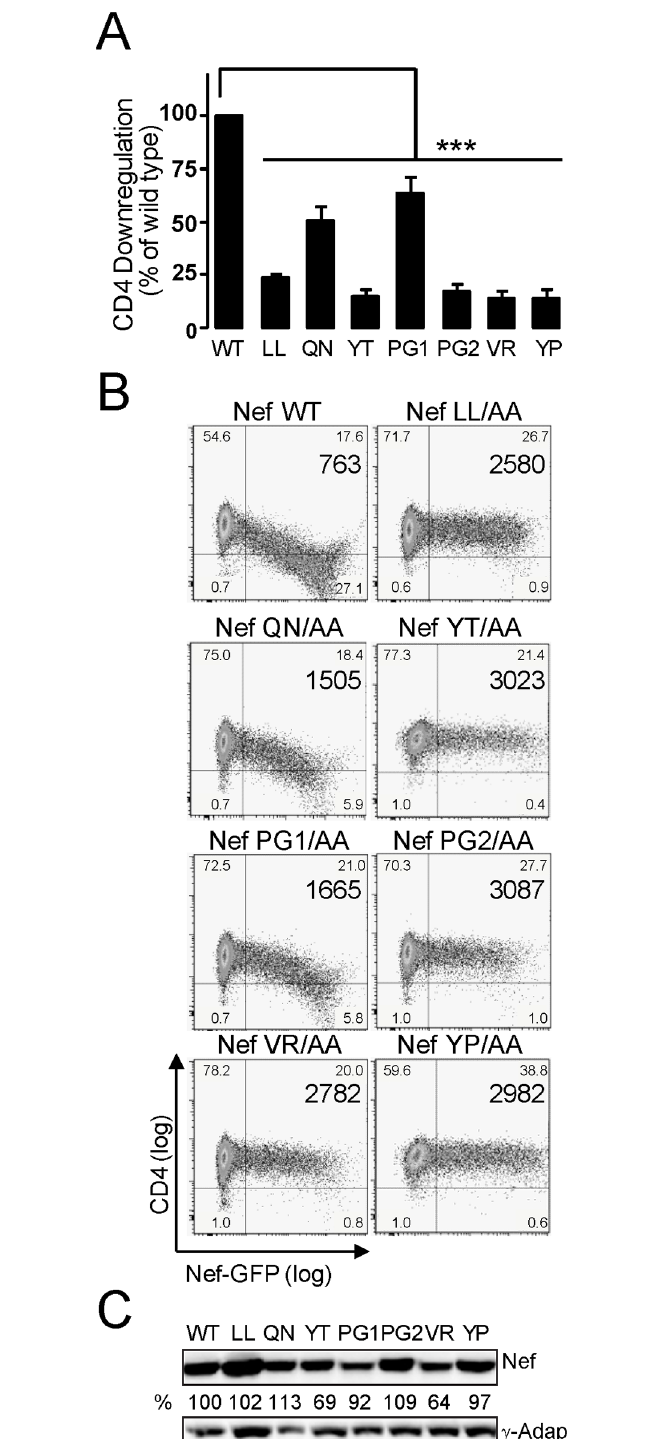
Fig 2. Mutations on the GPG-loop abrogate HIV-1 Nef-induced CD4 down-regulation. A-B) CEM cells were transfected with either wild type or the indicated Nef mutants as GFP-fusion proteins. Nef-induced surface CD4 down-regulation was analysed by two-colour flow cytometry in Nef-GFP expressing cells. The mean CD4 (PE) fluorescence intensity (MFI) of the GFP-positive cells was used to calculate the Nef activity on surface CD4 expression (A). Histograms represent the percentage of activity relative to wild-type Nef